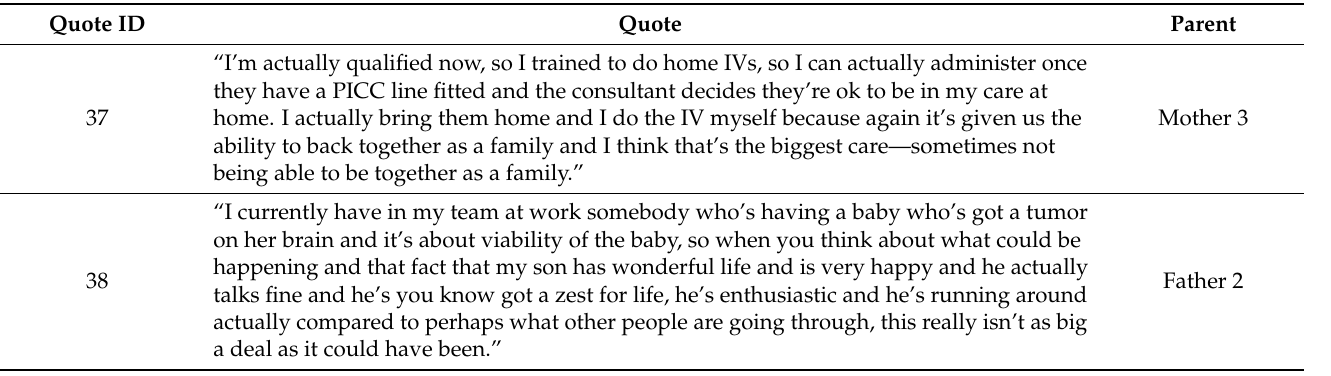
Table 6. Quotes from parents on their coping strategies following diagnosis.